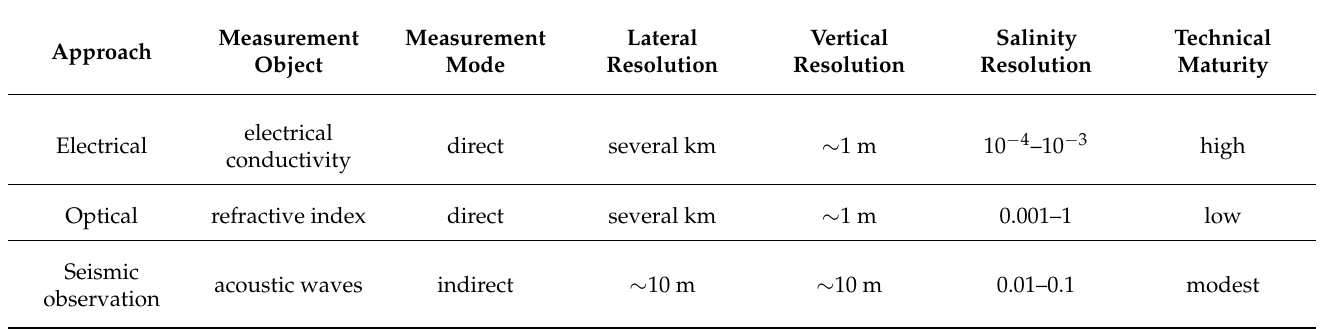
Table 6. The comparison of different salinity measurement